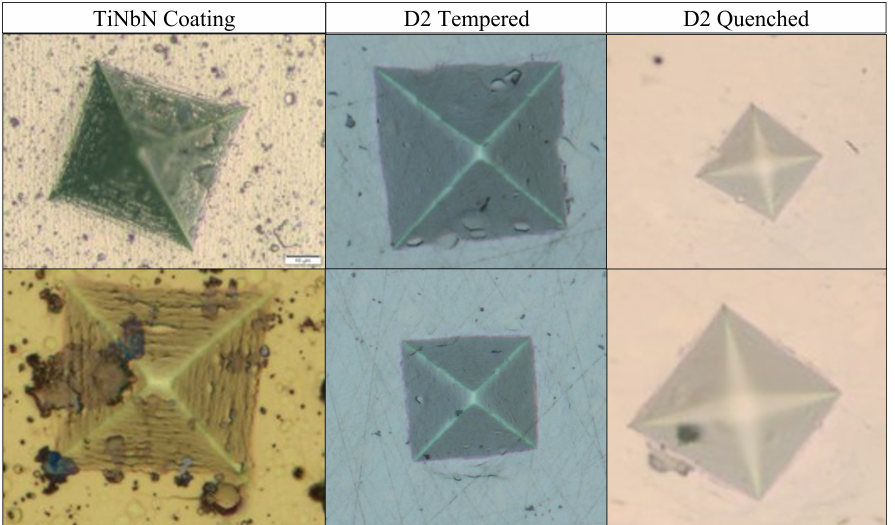
Figure 2. Example of indentation images used for the development of the proposed